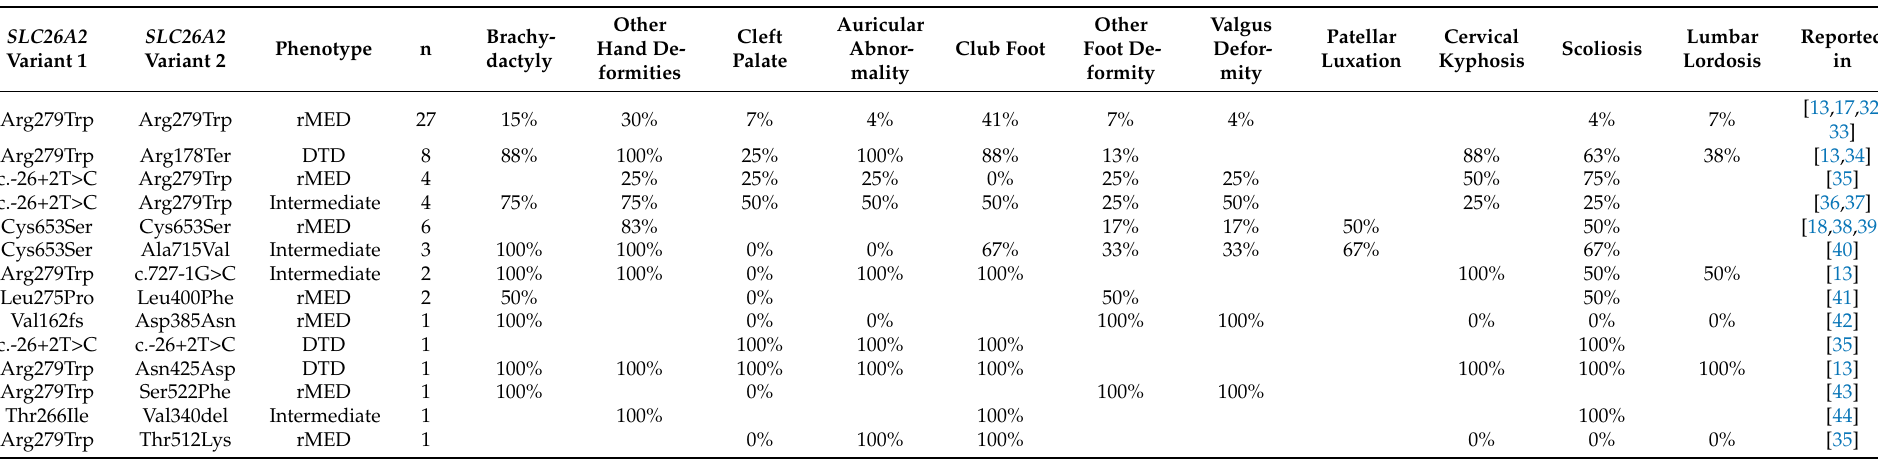
Table 4. Genetic and clinical findings in previously reported non-Finnish subjects and cohorts with SLC26A2 -related DTD and rMED. Empty spaces indicate that detailed data were not available for the specific